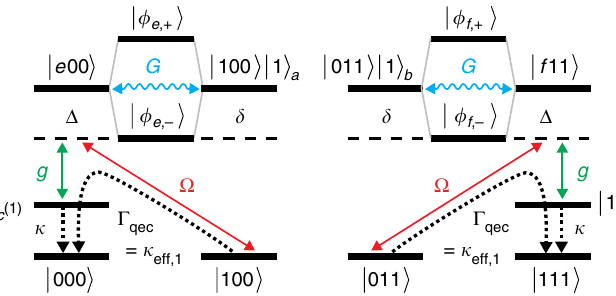
Fig. 3 Error correction mechanism. The states after a spin- fl ip on ion 1, | 100 〉 and | 011 〉 , are off-resonantly excited to the excited states | e 00 〉 (left) and | f 11 〉 (right). The strong sideband coupling G results in the formation of the dressed states | ϕ e / f , ± 〉 . For Δ = δ = G , the lower dressed states | ϕ e / f , − 〉 are in resonance with the drives from the single-error states, allowing for their selective excitation. The excitations in | e 〉 and | f 〉 are transferred from the ion to the auxiliary mode c (1) by a coherent coupling, g , and removed by cooling, κ , maintaining the coherence between the two paths | 100 〉 → | 000 〉 and | 011 〉 → | 111 〉 . Correction of spin- fl ips on other ions j is performed in the same way, utilizing the auxiliary mode c ( j